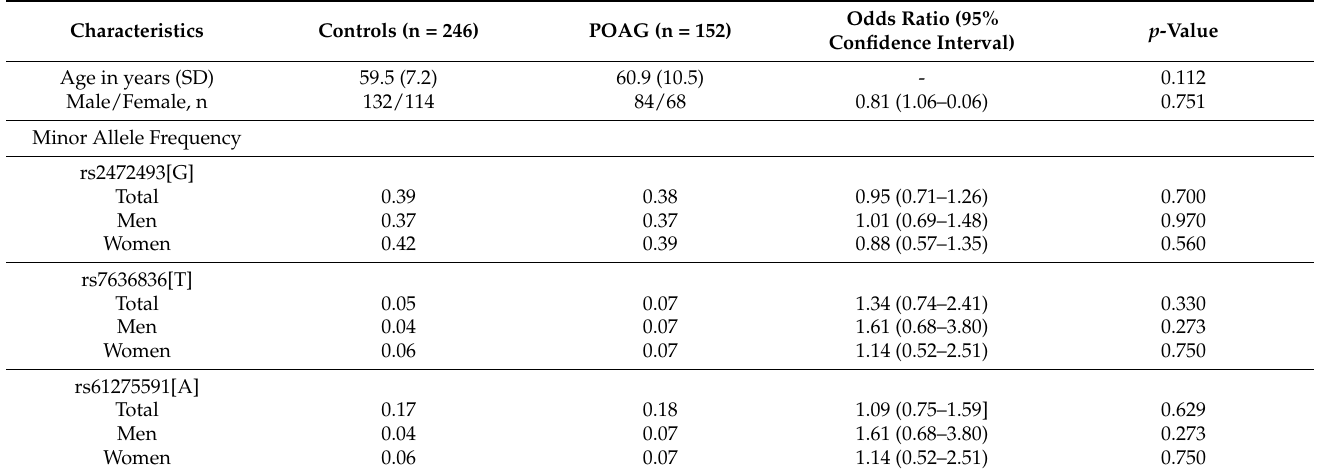
Table 1. Demographic characteristics and distribution of minor allele frequency of study participants.